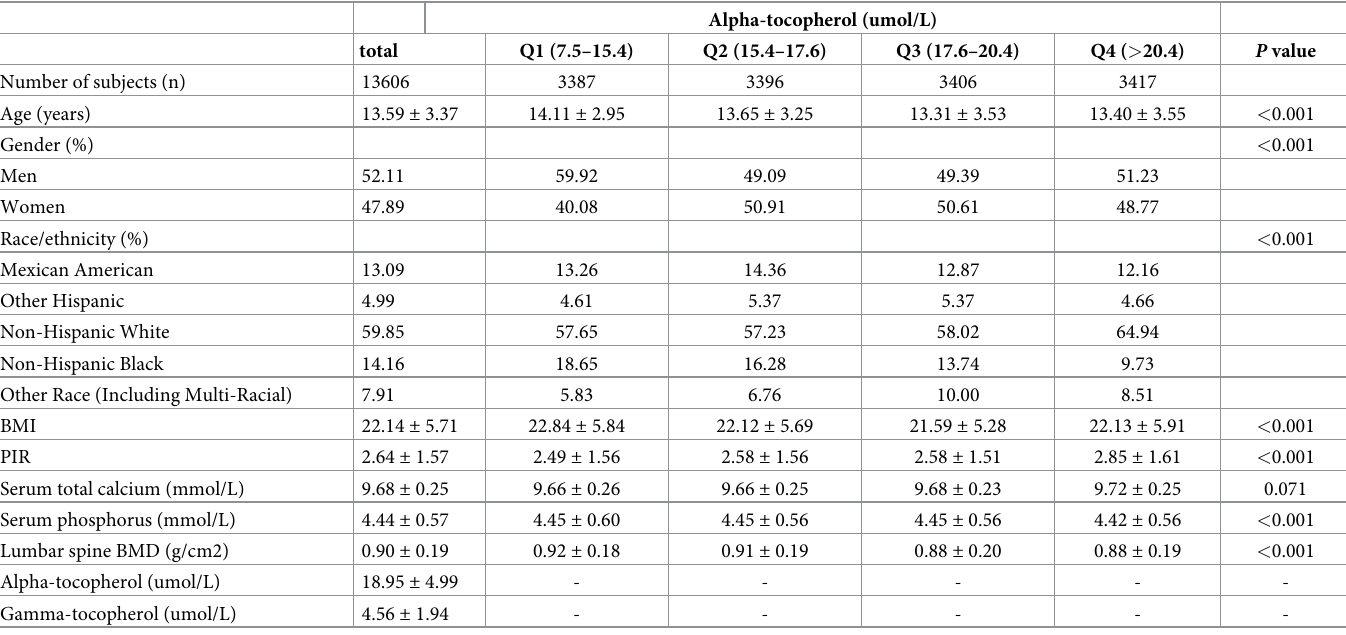
Table 1. Characteristics of the study population based on alpha-tocopherol